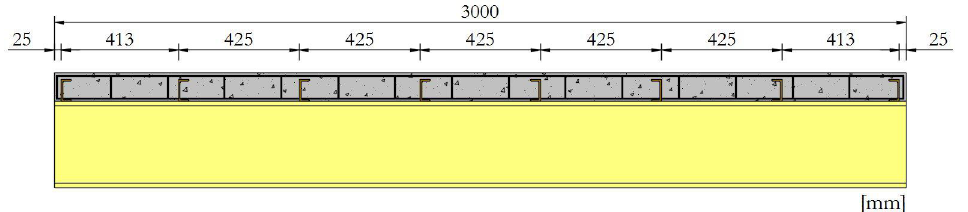
Figure 9. Positioning of shear connectors on the beam.